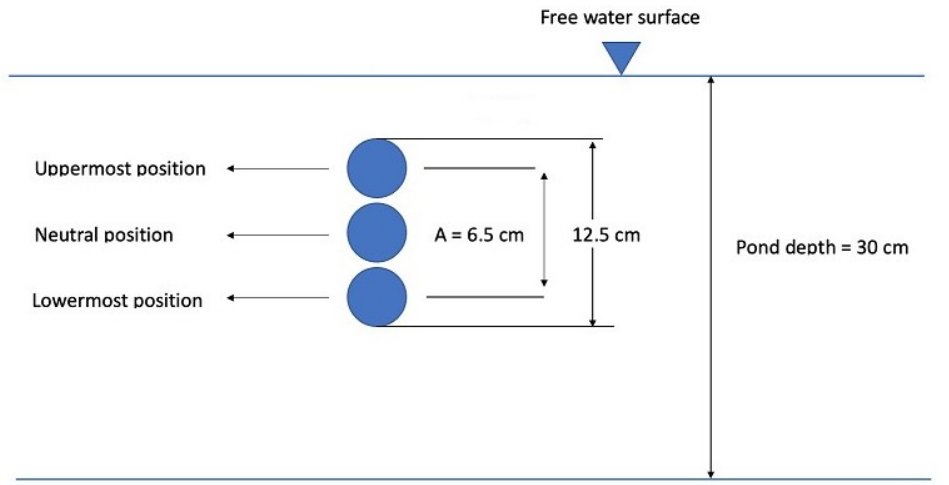
Figure 5. A view of experimental RWP with VIV system: General view of RWP with VIV system ( right ), Detailed view of VIV system ( left ).